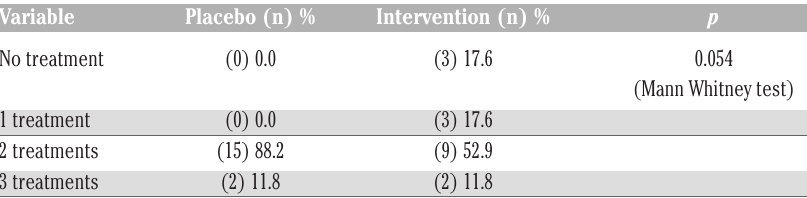
Table 1. Number of treatment cycles during induction therapy (phase I).